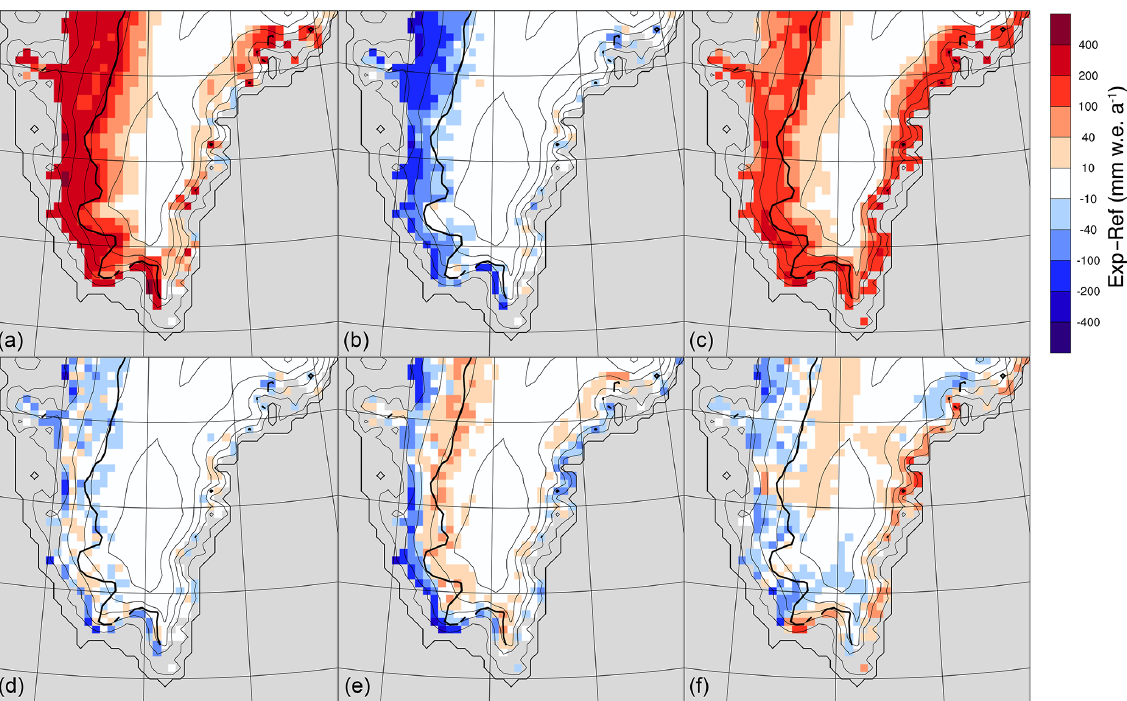
Figure 9. Difference in modelled SMB compared to the reference run from six of eight sensitivity test runs at 20km resolution; October 2007 to September 2014 average: ( a , run 1) uniform 10m firn layer, ( b , run 4) a reduced bare-ice albedo by 0.04 to 0.38, ( c , run 5) the soot concentration in the snow halved to 0.05ppmv, ( d , run 6) the roughness length of momentum of bare ice increased to 10cm, and ( e , run 7; f , run 8) equal roughness lengths of momentum, heat, and moisture, with 1cm over ice and (run 7) 1mm or (run 8) 0.1mm over snow. In all figures the equilibrium line in the reference run is drawn with a thick line for